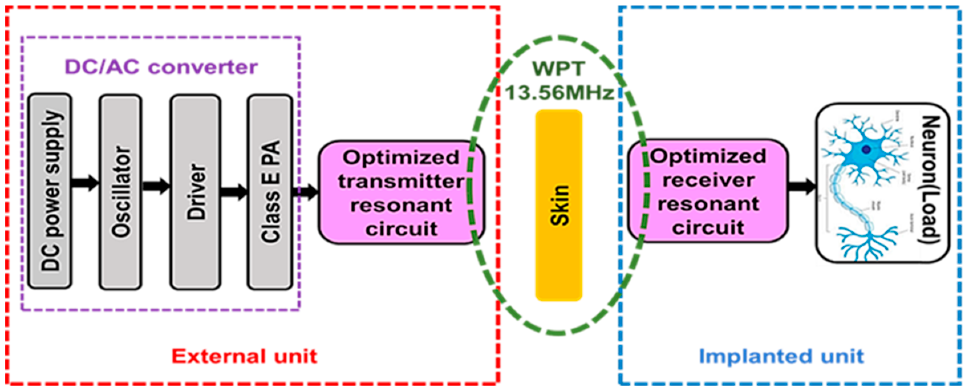
Figure 2. Schematic diagram of the proposed system.